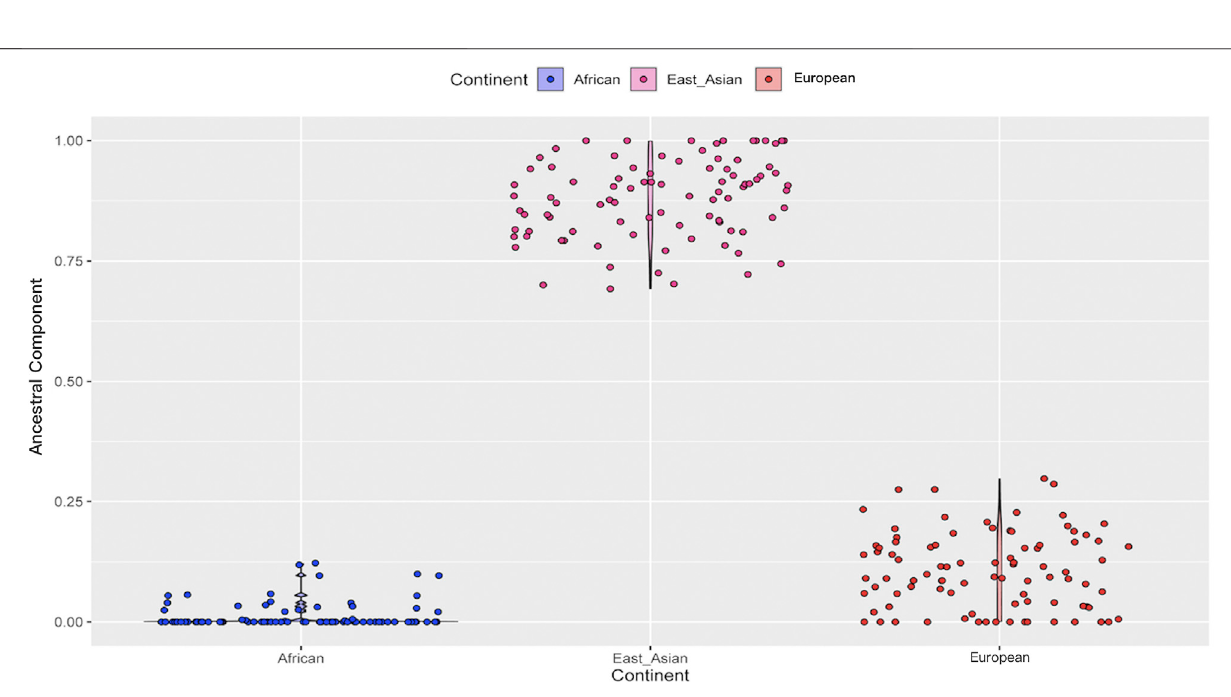
vertical line partitioned into several segments corresponding to the contributions of different ancestral components. For example, when K (cid:2) 2 (top line, Figure 8 ) was taken into consideration, all